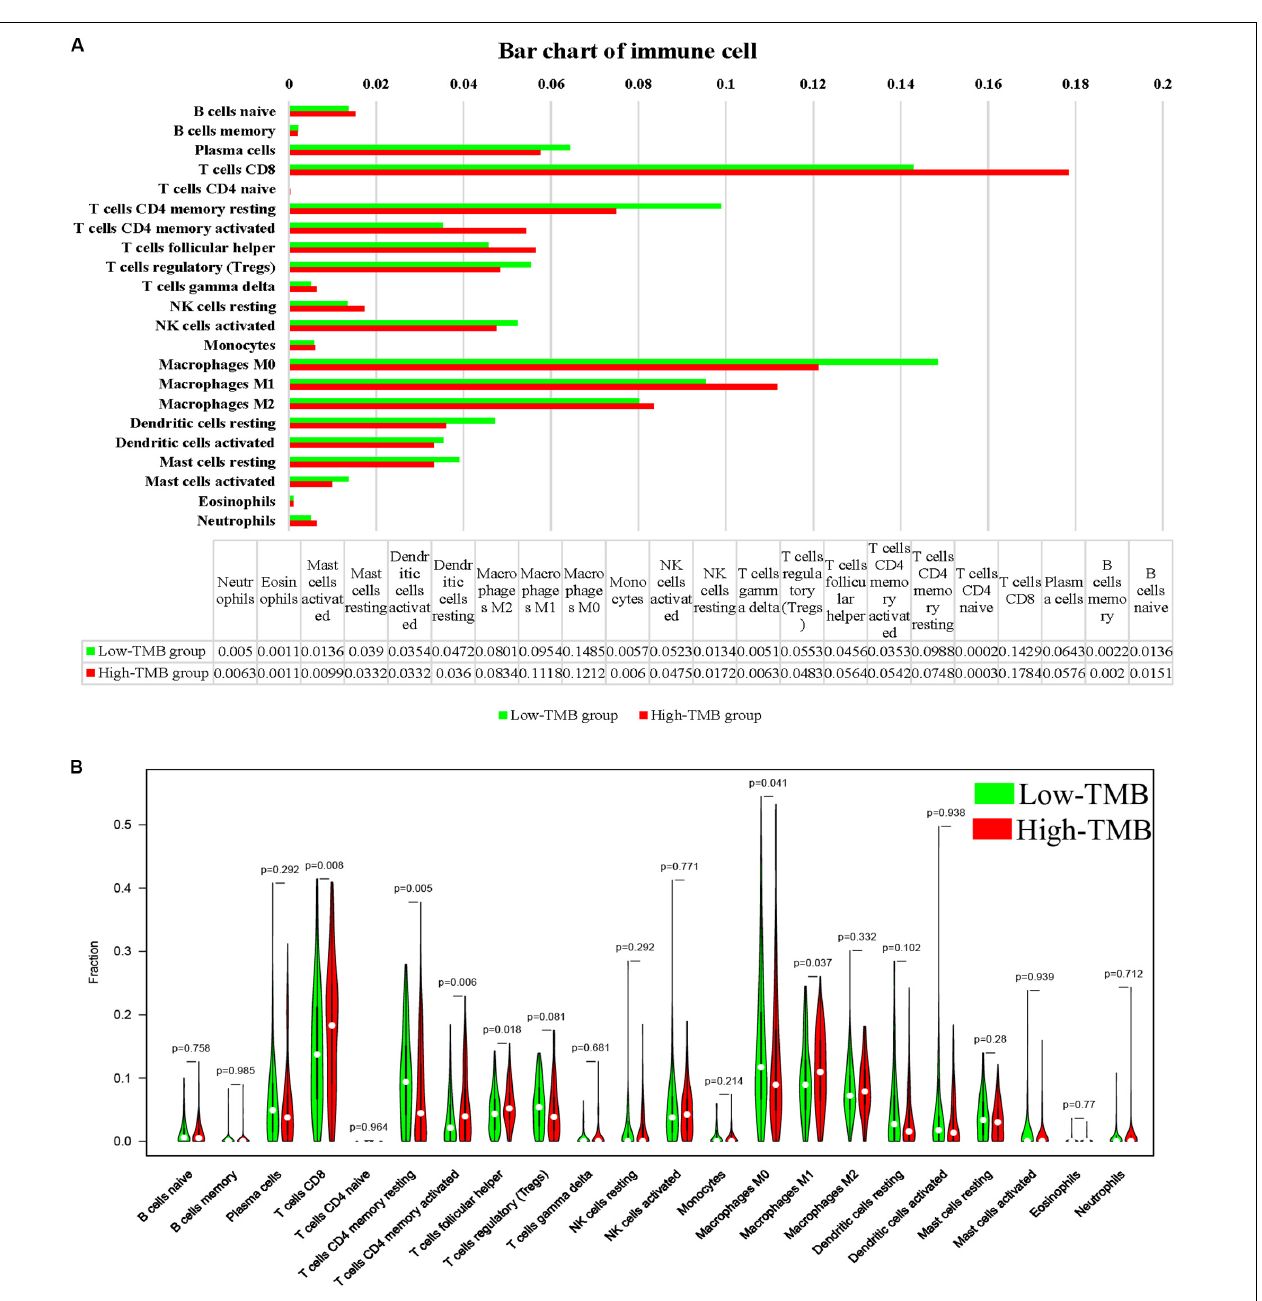
FIGURE 6 | Relationship between the TMB and immune cell. (A) The proportion of immune cells in the high- and low TMB subtypes. (B) The vioplot contains 22 kinds of immune cells, each of which is shown in red in the high mutation burden group and green in the low mutation burden group. TMB, mutant tumor burden.